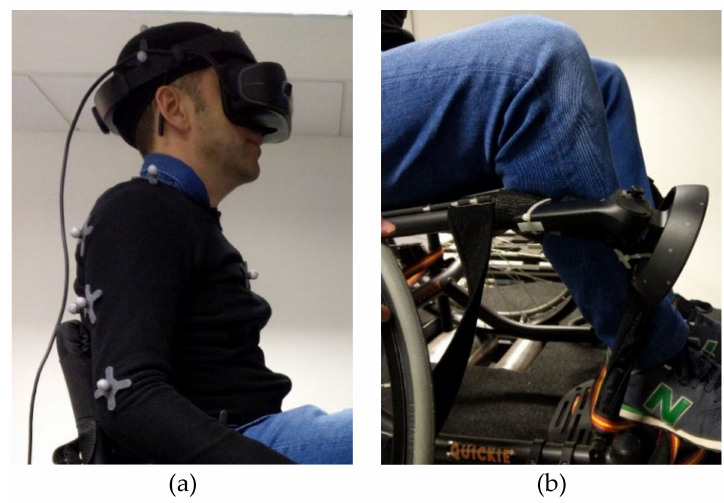
Figure 9. ( a ) User wearing the Lenovo Windows Mixed Reality Headset; ( b ) VR controller anchored to the